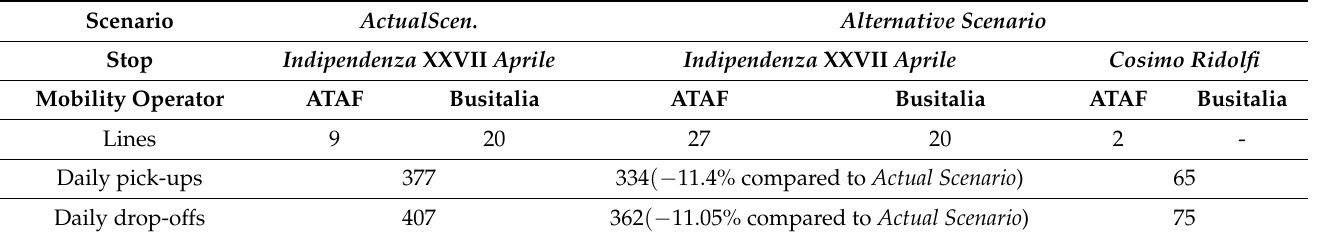
Table 6. The comparison of Actual Scenario and Alternative